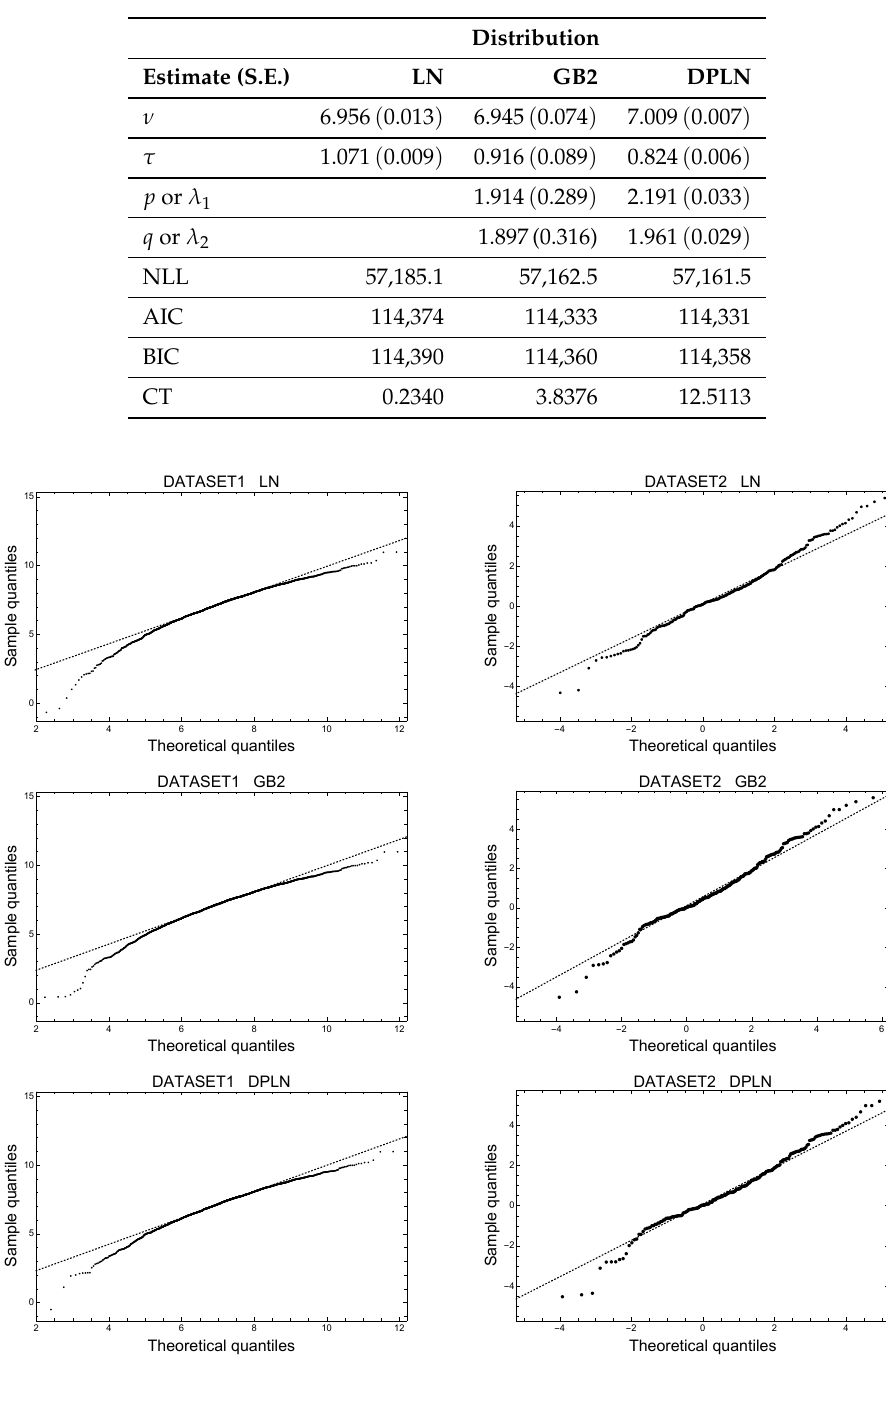
Figure 2. QQ-plots of the log-residuals for LN ( above ), GB2 ( middle ) and DPLN ( below ) generalized linear models for automobile insurance claims data ( left panel ) and automobile bodily injury claims ( right panel